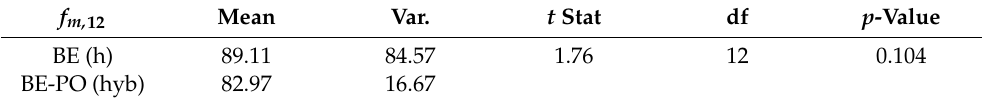
Table 5. Unpaired two sample t -test results for the glue-laminated beams—bending strength. f m, 12